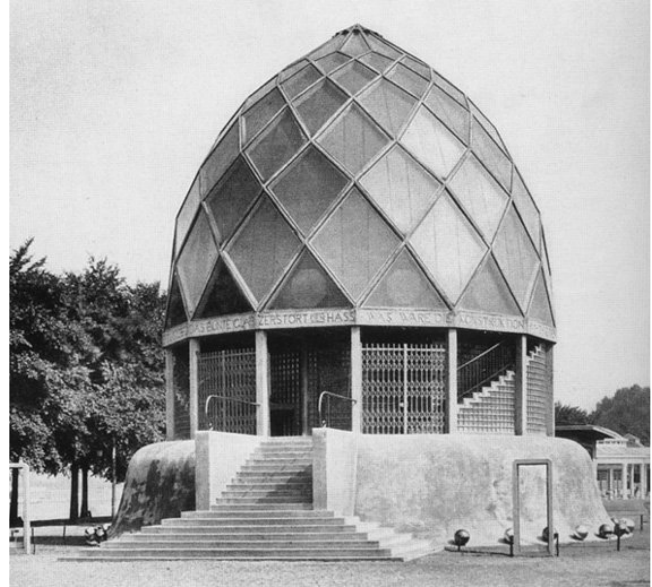
Figure 1. The Glass Pavilion, designed by Bruno Taut, Cologne Werkbund Exhibition, 1914 (public domain).